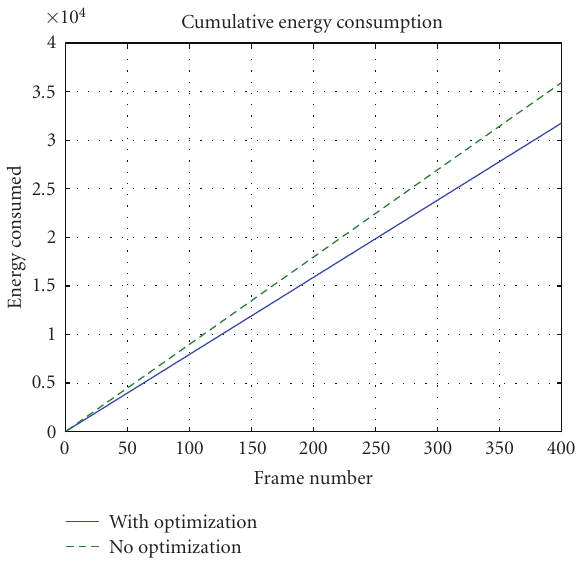
Figure 13: Energy consumption with and without optimization for Foreman video